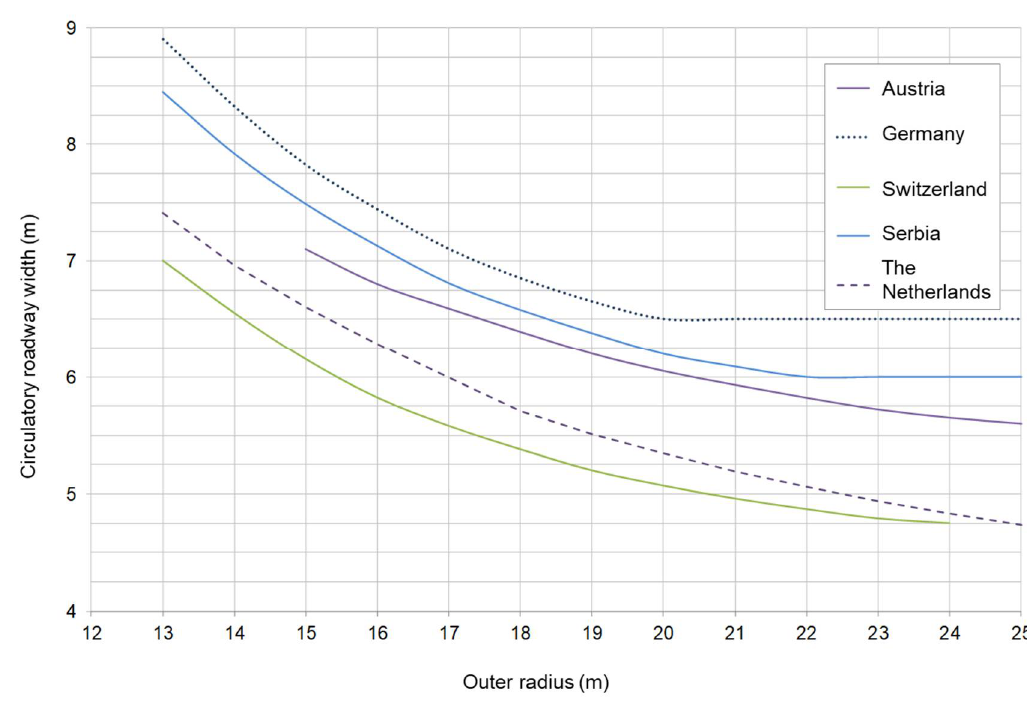
Figure 9. Standard circulatory roadway widths for suburban single-lane roundabouts [8,11].